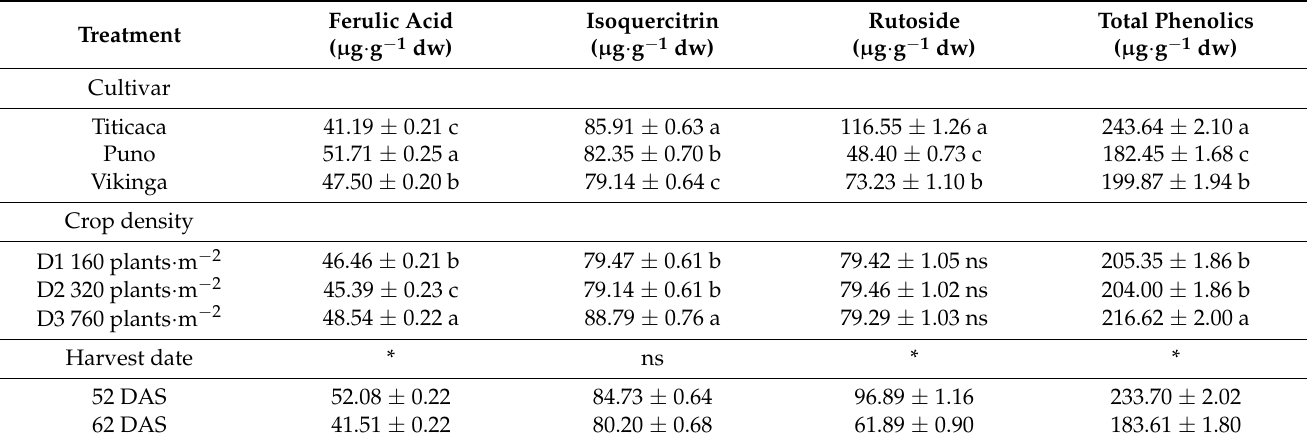
Table 7. Cultivar, plant density and harvesting time effect on phenolic compounds in quinoa leaf cultivars.